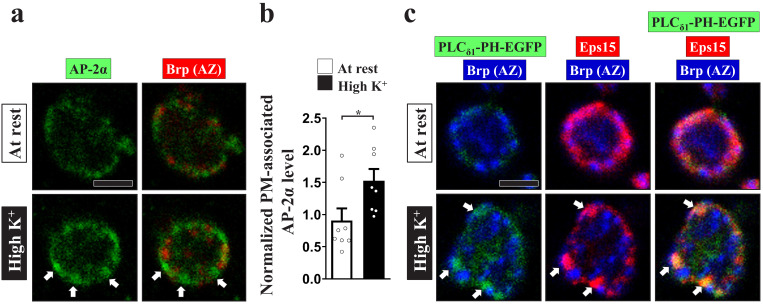
PI(4,5)P2 is increased at the periactive zone upon intense stimulation.(a–b) AP-2 complex was actively recruited to the plasma membrane after the boutons were intensely stimulated. (a) Single-plane confocal images of NMJ boutons stained with α-AP-2α. The boutons were subjected to the resting condition (10 min incubation of 5 mM K+/0 mM Ca2+) or high K+ stimulation (10 min stimulation of 90 mM K+/2 mM Ca2+), followed by chemical fixation and α-AP-2α immunostaining (green). Active zones were labeled with Brp staining (red). An increase in AP-2α immunostaining signal was observed at the periactive zones (arrows). (b) Quantification data for the plasma membrane-associated α-AP-2α immunostaining intensities, normalized to the value of the resting condition. Individual data values are shown in graphs. p values: *p<0.05. Mean ± SEM. Scale bar: 2 µm. Statistics: Student t-test. (c) Upon high K+ stimulation, PLCδ1-PH-EGFP accumulated in PI(4,5)P2-enriched microdomains at the periactive zones. Single-plane confocal images of NMJ boutons neuronally expressing UAS-PLCδ1-PH-EGFP using nSyb-GAL4. The boutons were subjected to the resting condition (10 min incubation of 5 mM K+/0 mM Ca2+) or high K+ stimulation (10 min stimulation of 90 mM K+/2 mM Ca2+), followed by chemical fixation and immunostaining. Arrows indicate that Eps15 (red) was concentrated at the periactive zone and colocalized with PLCδ1-PH-EGFP (green) stained with α-GFP after intense stimulation. Brp (blue) labels active zones. Scale bar: 2 µm.
Figure 1—figure supplement 3—source data 1.Source data for Figure 1—figure supplement 3.